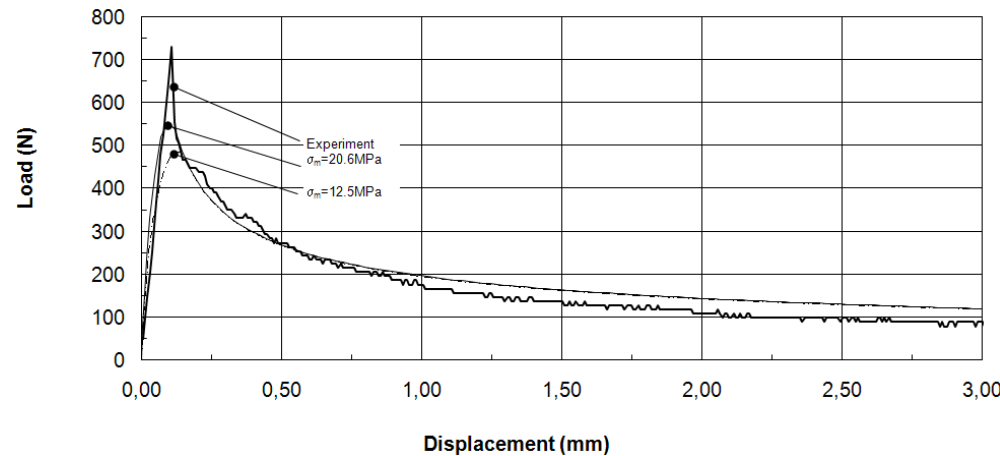
Figure 6: Comparison between experiment and T-peel simulations (ACZ model).